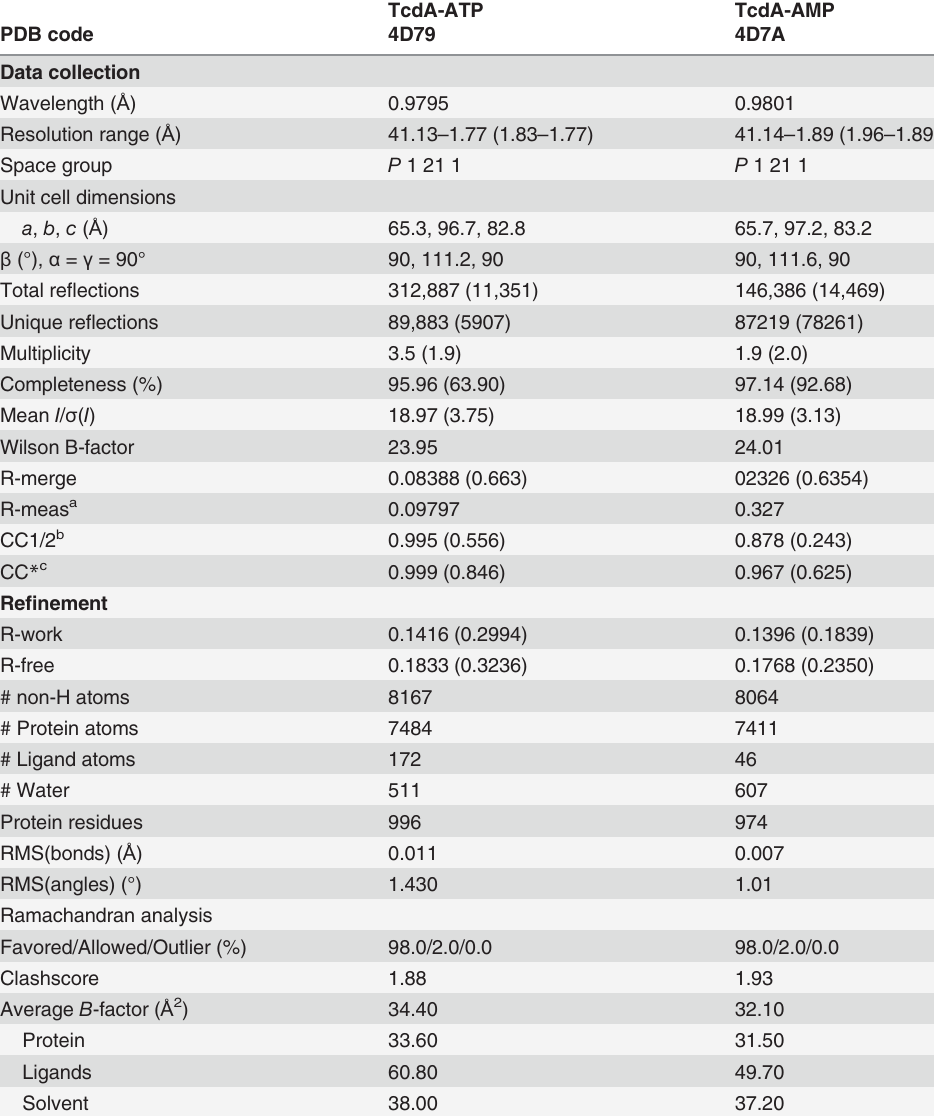
Table 1. Crystallographic data processing and refinement